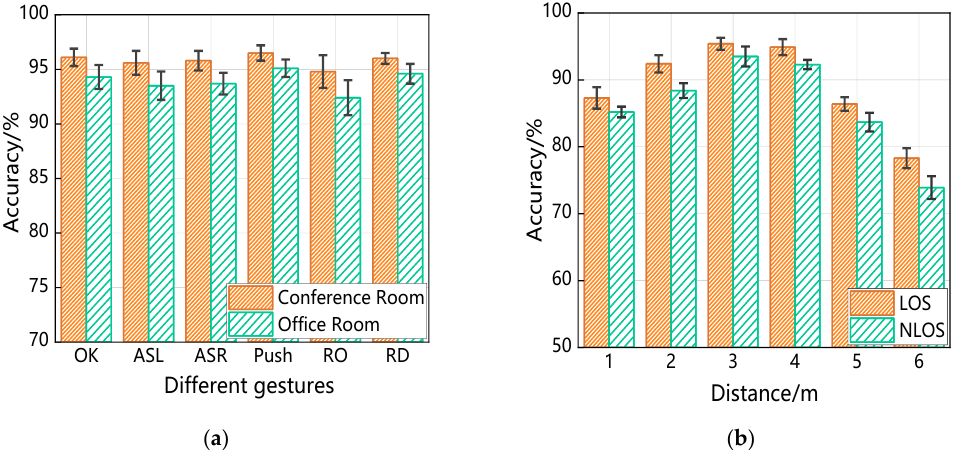
Figure 12. The impact of cross-domain on gesture recognition: ( a ) The effect of different environments on gestures. ( b ) The effect of device distance on gestures.